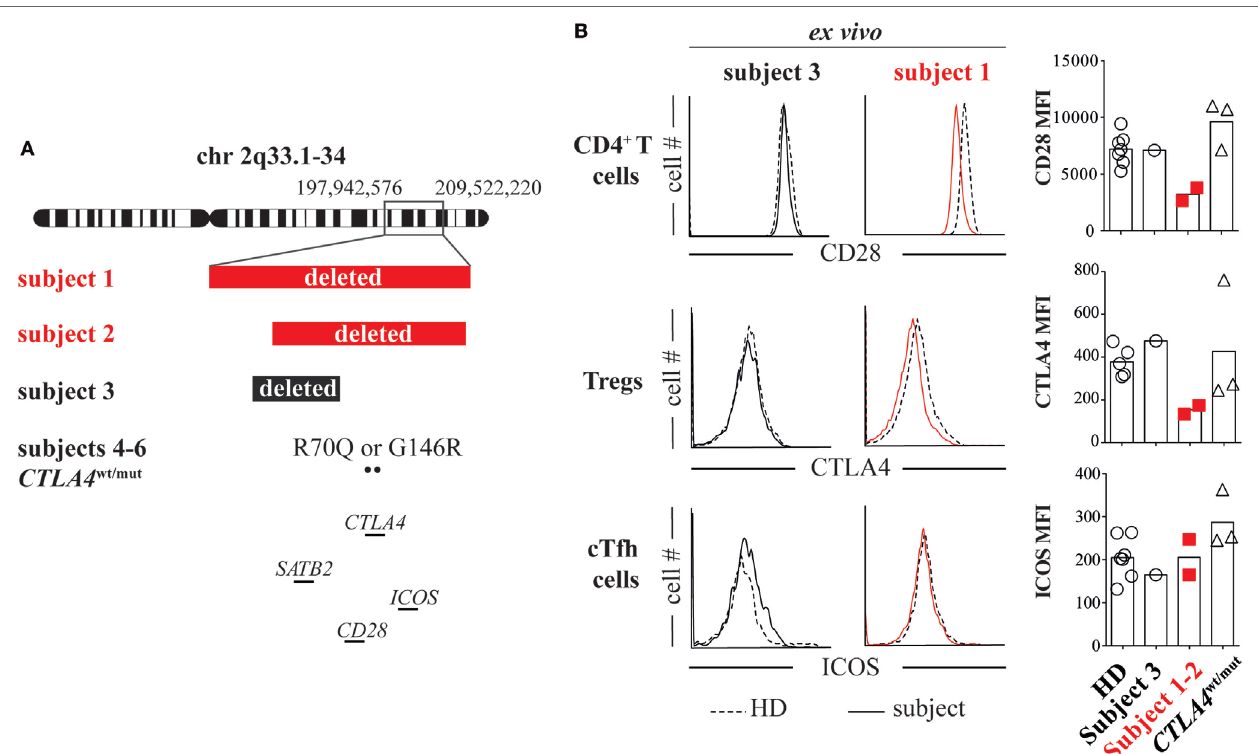
FIGURe 1 | Heterozygous loss of the CD28 / CTLA4 / ICOS gene cluster decreases CD28 and cytotoxic T-lymphocyte-associated protein 4 (CTLA4) but not inducible T-cell costimulator (ICOS) expression. (a) Chromosome 2 breakpoints and mutation locations for subjects 1 through 6 are depicted. (B) Ex vivo CD4 + T cell CD28 expression, T regulatory cell (Treg) (CD127 low CD25 high ) CTLA4 expression and ICOS expression on cTfh cells (CXCR5 + PD1 + ) were assessed in subject 1 (red line), subject 3 (black line), and healthy donor (HD, dashed line) blood samples by flow cytometry. CD28, ICOS, and CTLA4 average mean fluorescence intensities (MFIs) from subjects and HDs are summarized